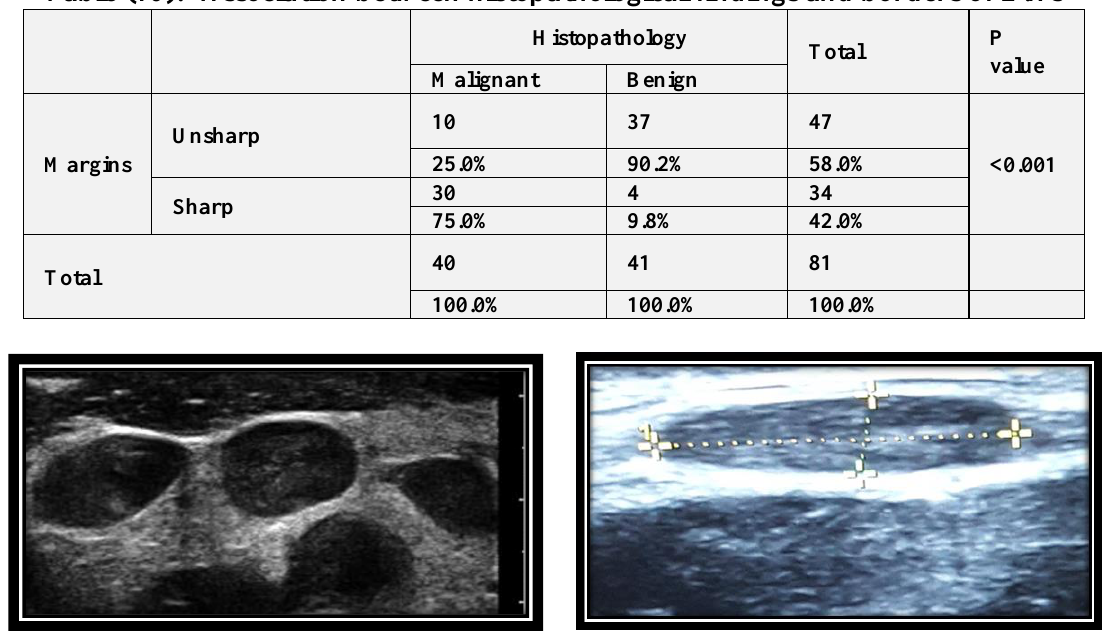
Figure(3):-Lymph nodes with sharp borders. Figure (4):-Lymph nodes with unsharp